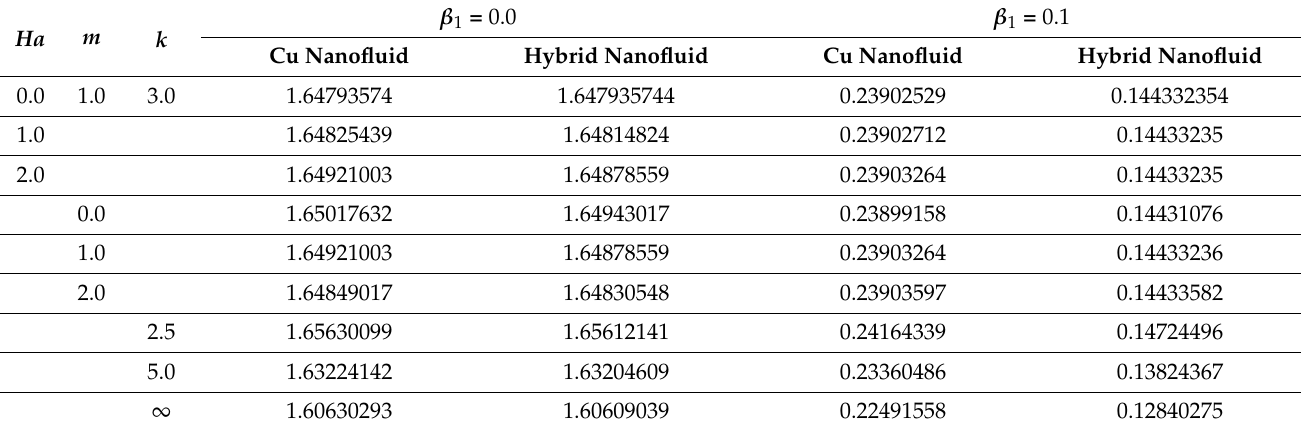
Table 4. Change in skin friction with γ 1 = 1.0 and q = − 0.2.